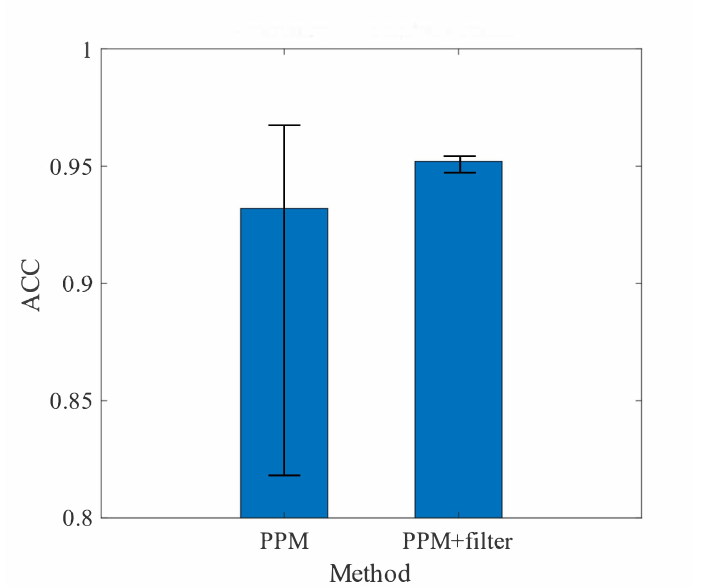
Figure 9. Prediction accuracy of the PPM . The bars on the histogram indicate the range of prediction accuracy in different